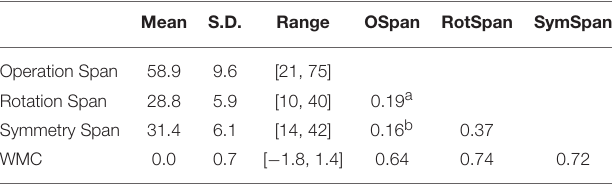
TABLE 1 | Descriptive statistics for the complex span tasks and their composite score (WMC) as well as the correlations between all measures. Mean